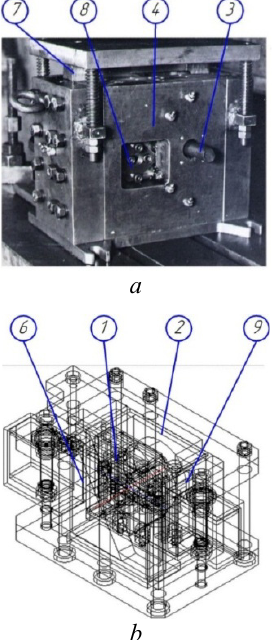
Figure 12. Photograph (a) and 3D model of the stamp with a differentiated clamp (b) Table 2. Recommendations for the design of stamps with the differentiated clamp of rolled stocks